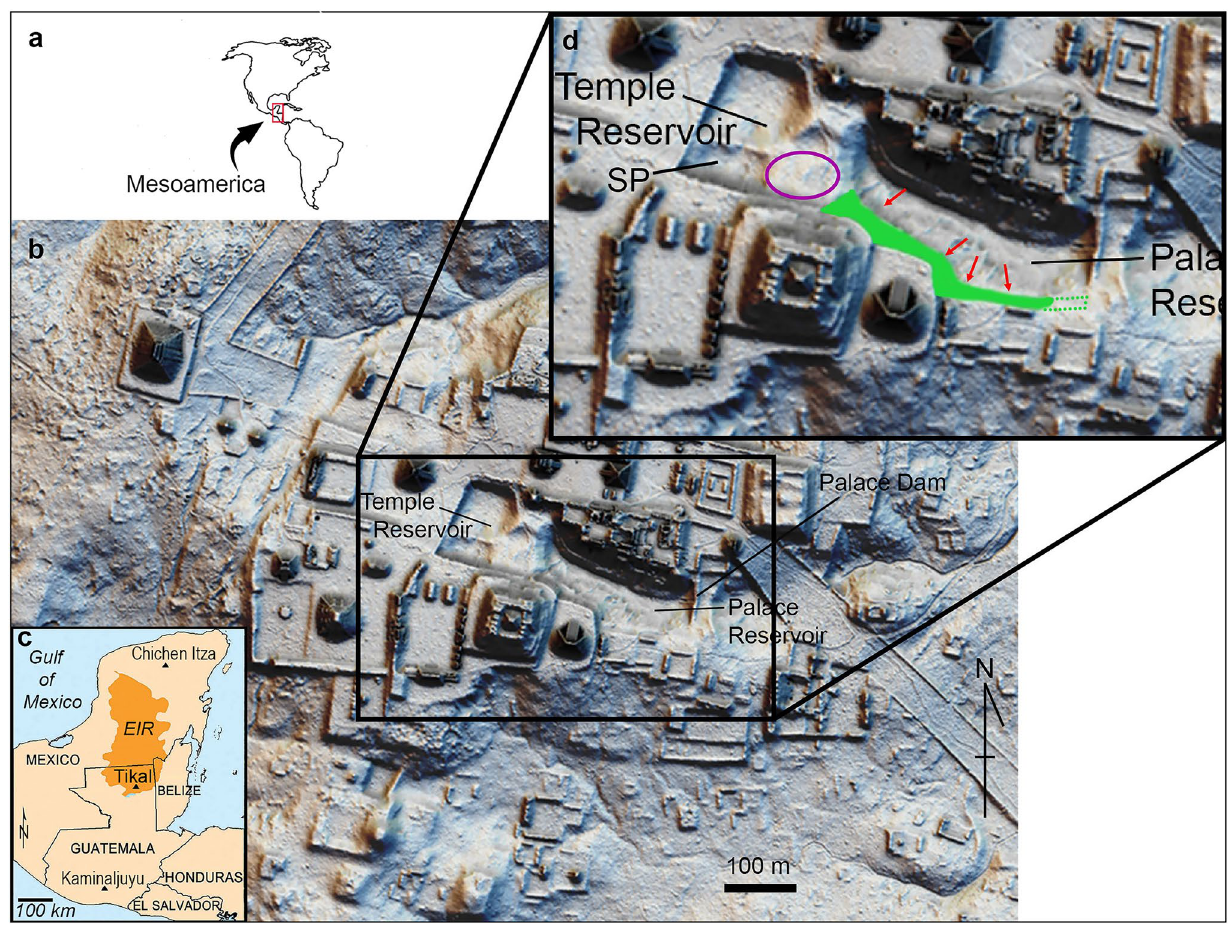
Figure 1. Lidar images of Tikal showing the location of the Palace and Temple reservoirs within the central precinct of the city. Providing water for large urban populations in this region was a challenge because there were no permanent lakes or rivers and the geological under-bedding is porous calcium carbonate. The map of the Western Hemisphere ( a ) shows the location of the Yucatan peninsula. The inset map ( c ) indicates the location of Tikal within the Yucatan peninsula and the extent of the elevated interior region (EIR). The central lidar image ( b ) presents a view of the site core of Tikal. The enlargement in the upper right corner ( d ) shows the water’s edge of the Palace reservoir (red arrows) and the location of the “bench” or vegetated embankment (green) discussed in the text. The location of the hypothesized “ancestral grove” is encircled in purple. The proposed silting tank or spring pool (SP) lies just to the west of the ancestral grove. The lidar image of the Tikal site core was courtesy of Francisco Estrada-Belli, MARI GIS Lab and the Fundación Patrimonio Cultural y Natural Maya-PACUNAM. Nicholas Dunning created the Mesoamerican inset map. David Lentz created the map of the Western Hemisphere and the final figure using Photoshop CS6, Vers. 13.0.1 × 64 (https:// www. adobe. com/ produ cts/ photo shop/ prici ng- info.